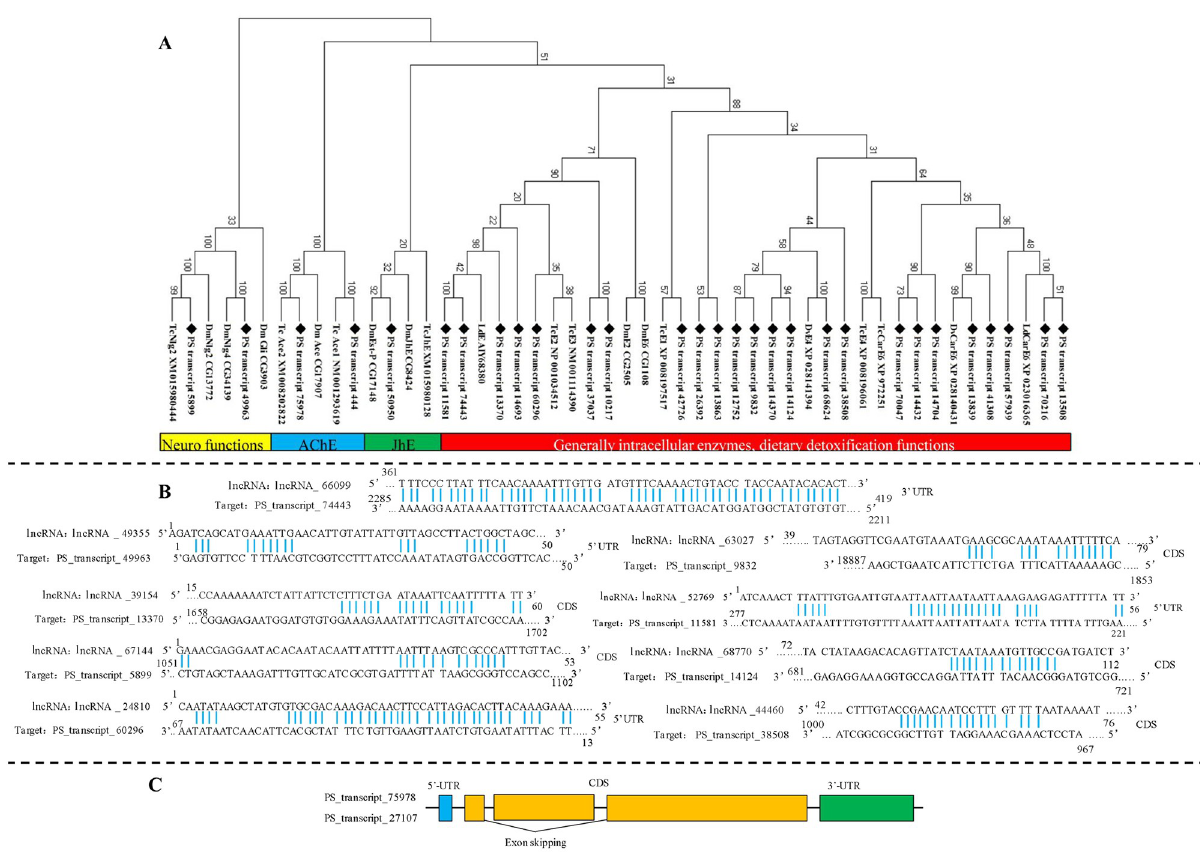
Fig 3. Sequence analysis, regulatory lncRNA, and splicing events of ESTs. A. Phylogenetic analysis of transcripts encoding ESTs; B. binding sites of lncRNA and ESTs; C. splicing events of ESTs.